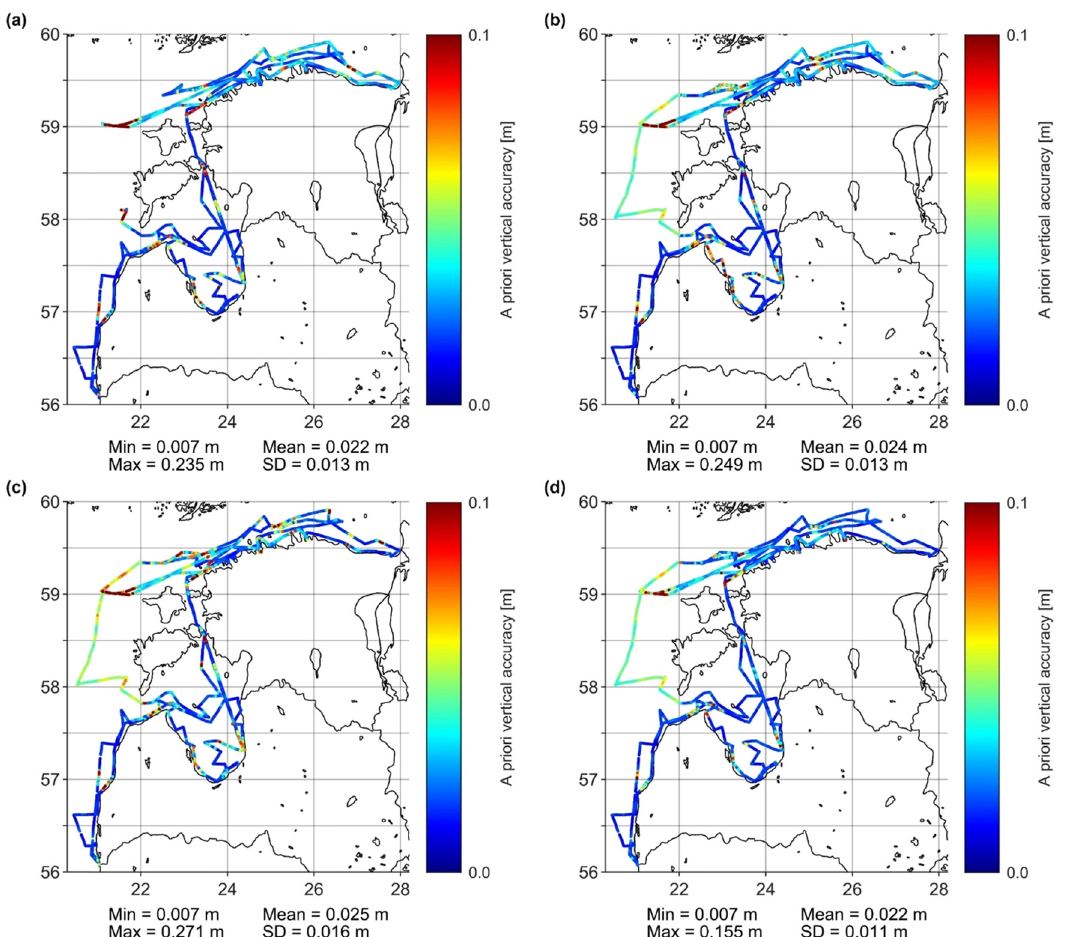
Figure 10: A priori vertical accuracies of antenna A1 ( a ) , A2 ( b ) , A3 ( c ) , and A4 ( d ) during all the campaigns. Note that the estimates westward 22°E meridian of C2 campaign ( cf. Figure 1 ) represent the CSRS -